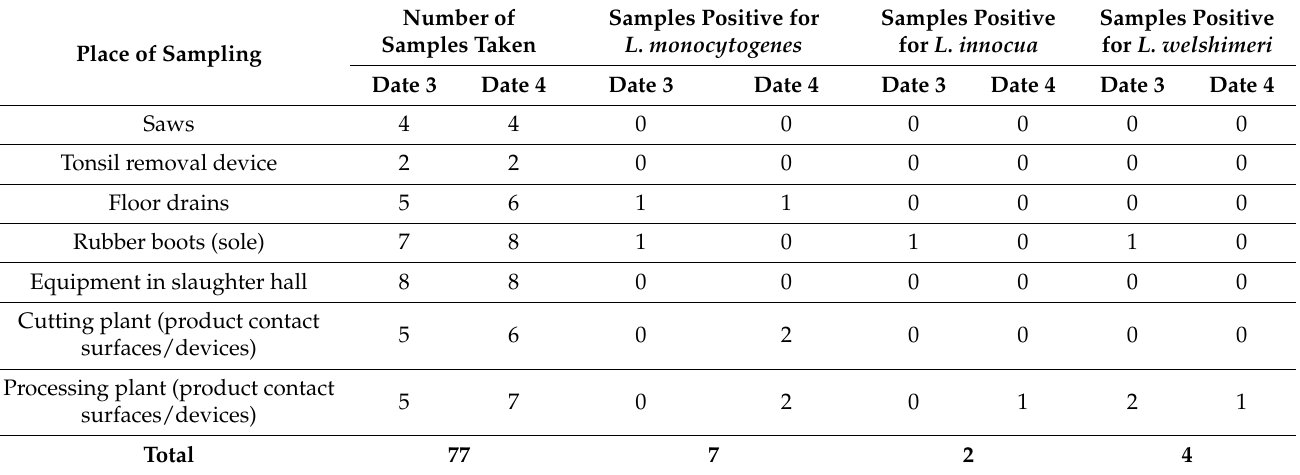
Table 1. Results of environmental samples taken on date 3 ( n = 36) and date 4 ( n = 41) in slaughter- house A in absolute